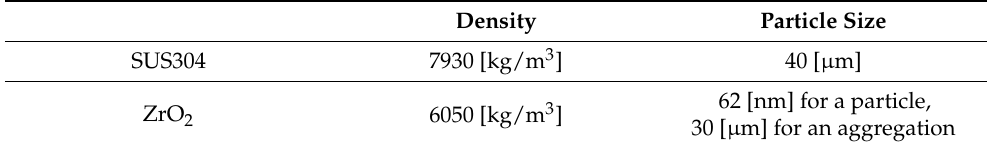
Table 2. Density and particle size of SUS304 and ZrO 2.